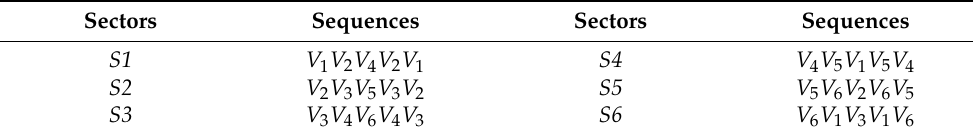
Figure 6. DC-bus utilization. Table 4. Voltage vector action sequences under CMRSVPWM II.